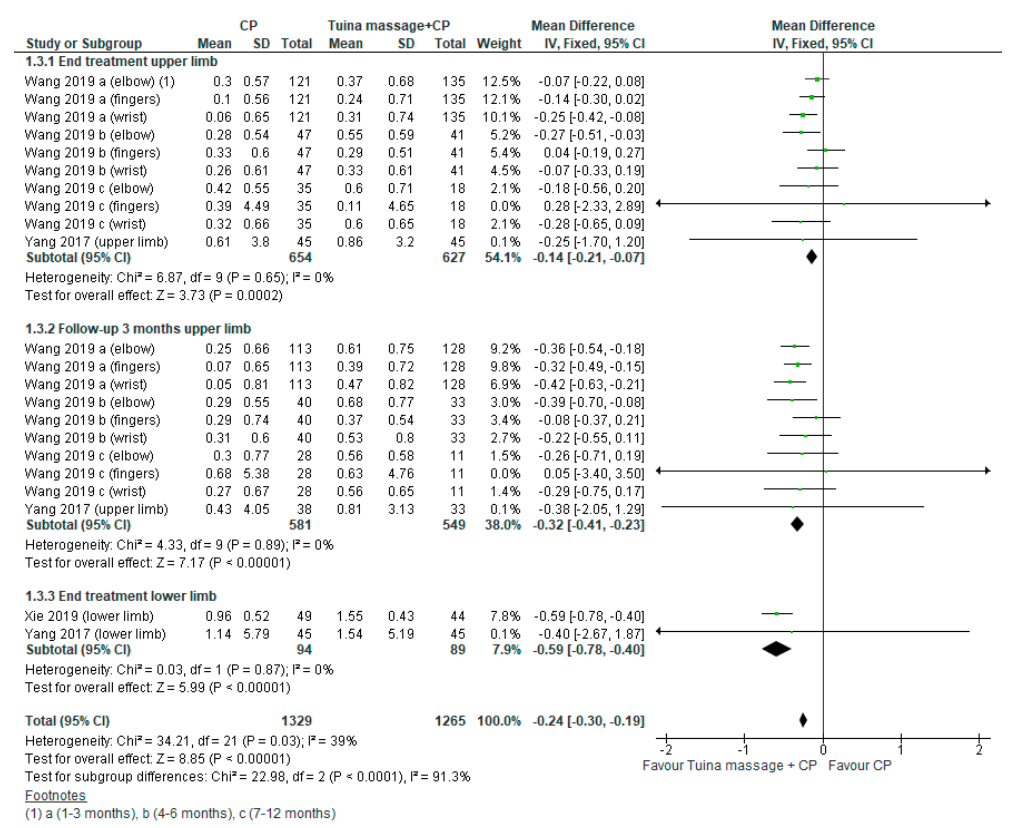
Figure 5. Forest plot of comparison Tuina massage plus conventional physiotherapy (CP) versus CP for upper/lower limbs spasticity evaluated by modified Ashworth Scale.